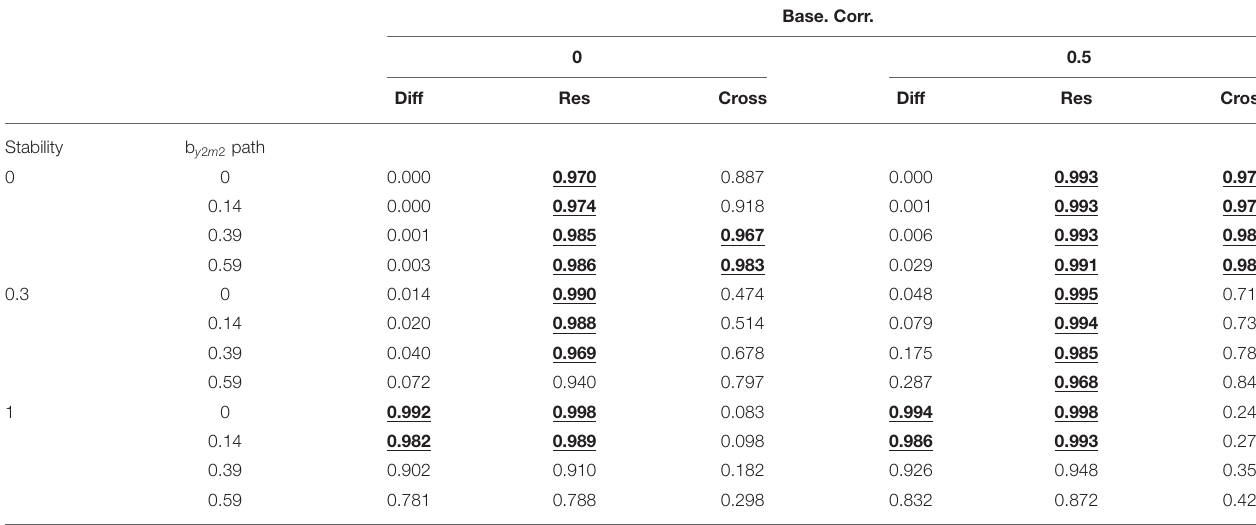
TABLE 1 | CFI values for the difference score model (Diff), residualized change score model (Res), and cross-sectional model (Cross) for M 2 cross-lag = 0 and Y 2 cross-lag = 0.